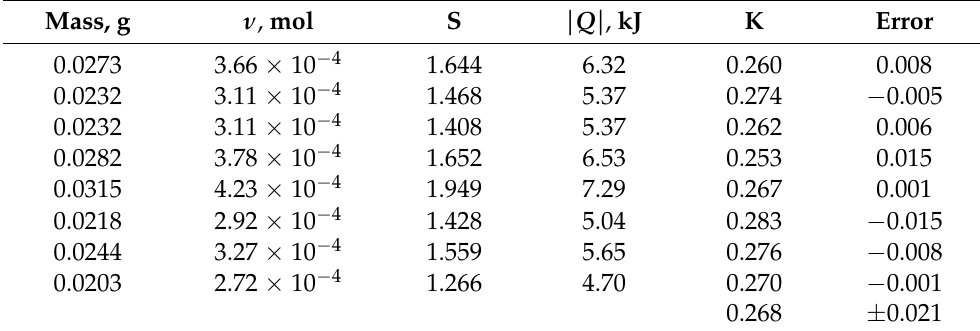
Table A2. Details of the ∆ H sol ( MgCl